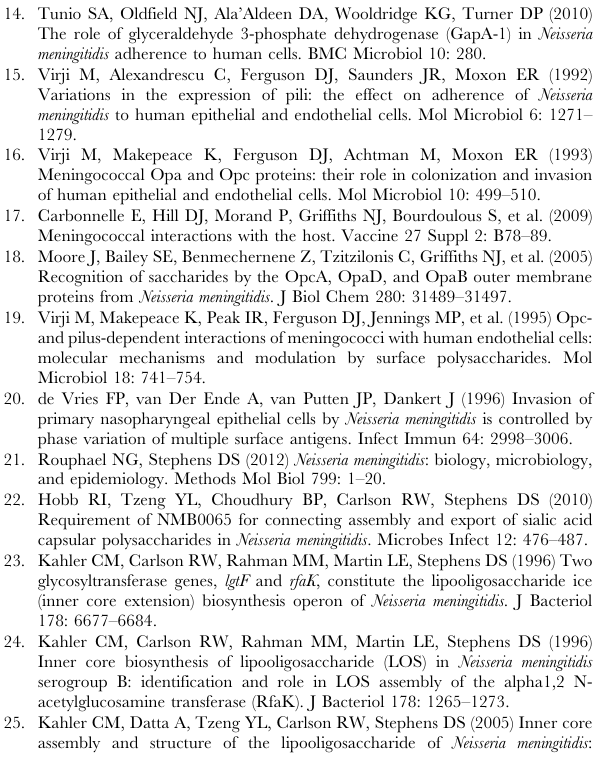
Figure S1 Venn diagram showing the distribution of genes as orthologous groups (OG) across four genomes representing ST-8 cc (NMB-CDC, G2136), ST-11 cc (FAM18) and ST-32 cc (MC58). Orthologous group (OG) clustering of open reading frames using a cut-off of 1e -50 to identify new genes in strain NMB-CDC versus those of G2136, FAM18 and MC58. Strain NMB-CDC most closely aligns with the ST-8 cc genome of strain G2136 with which it shares 1834 genes. In addition, strain NMB-CDC is more distantly related to strain MC58 with which it shares 1659 genes. The core or shared genome of the four isolates in this collection consists of 1579 genes. Strain MC58 from ST-32 cc was the most divergent from the other three genomes having 242 genes unique to this isolate.